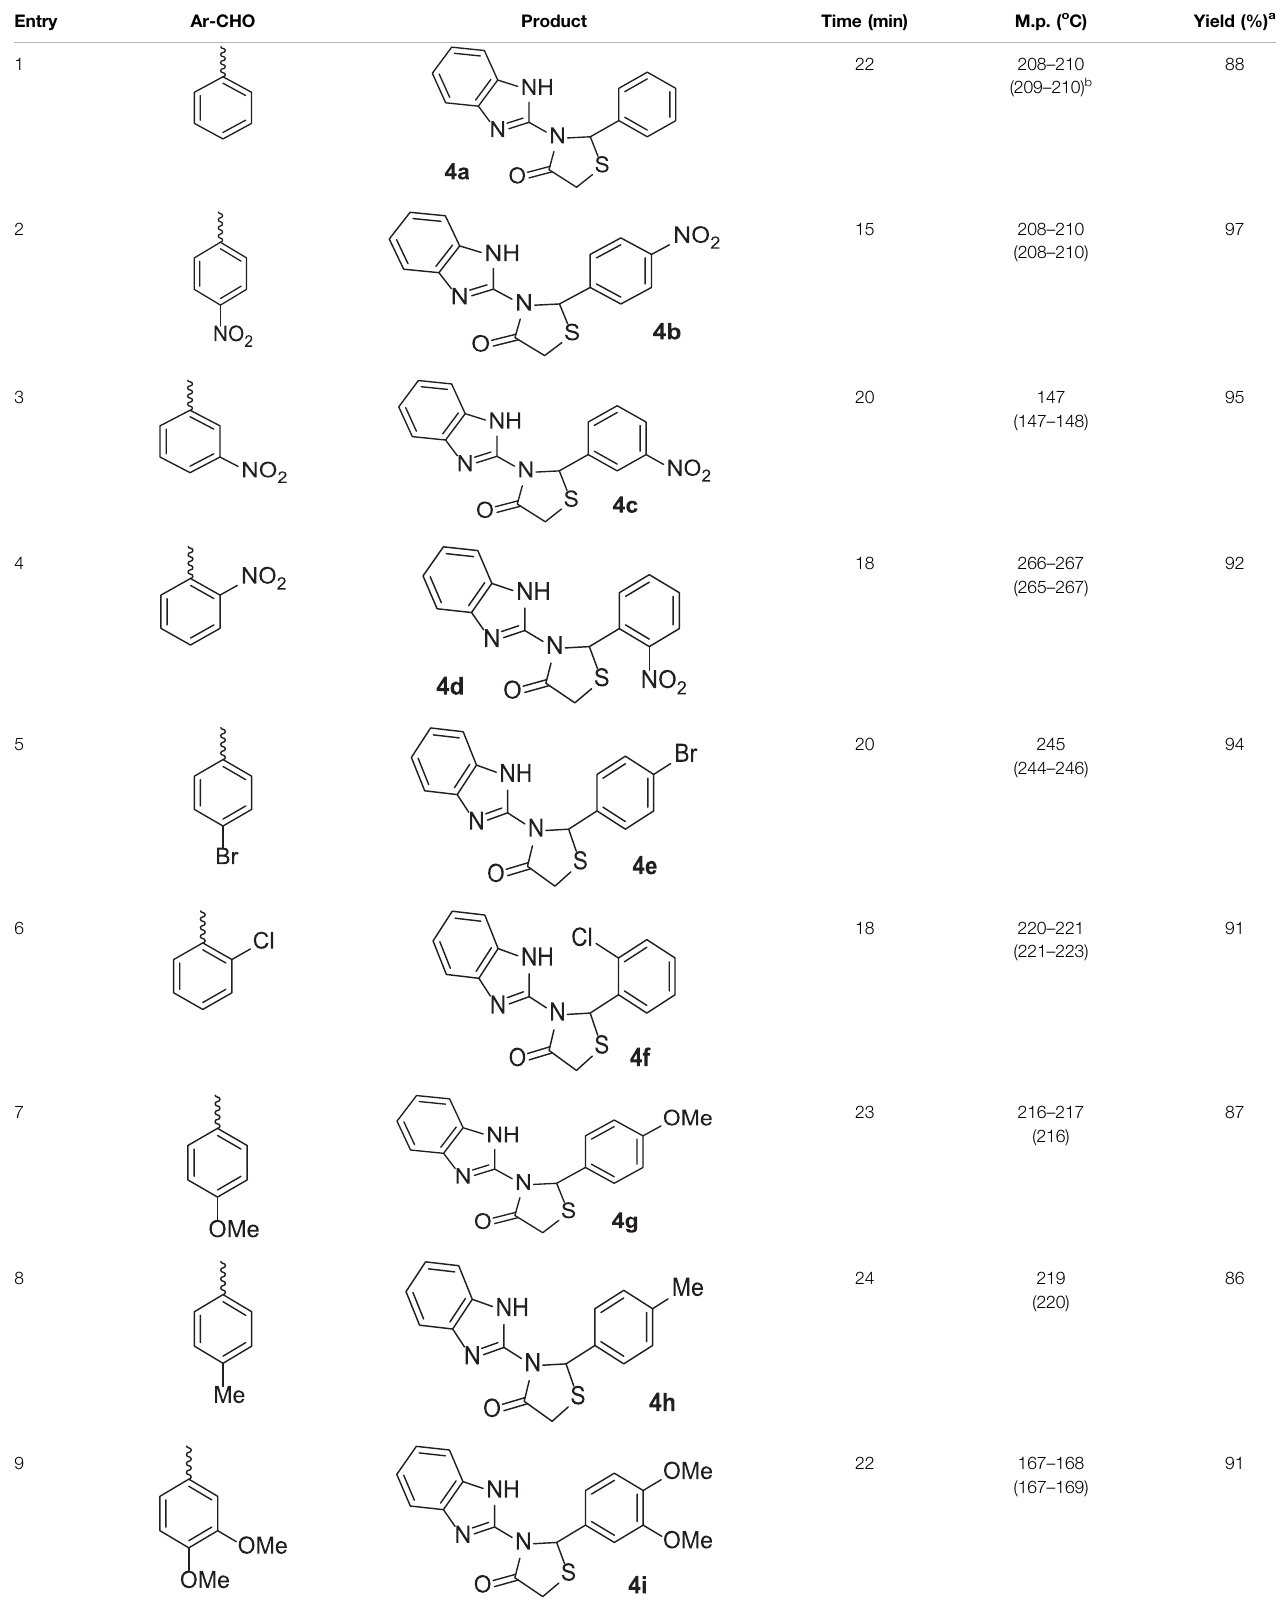
TABLE 3 | Synthesis of products 4a – n in the presence of 3 wt% of Pd/TCH-pr@SBA-15 and in an acetone/H 2 O mixture at room